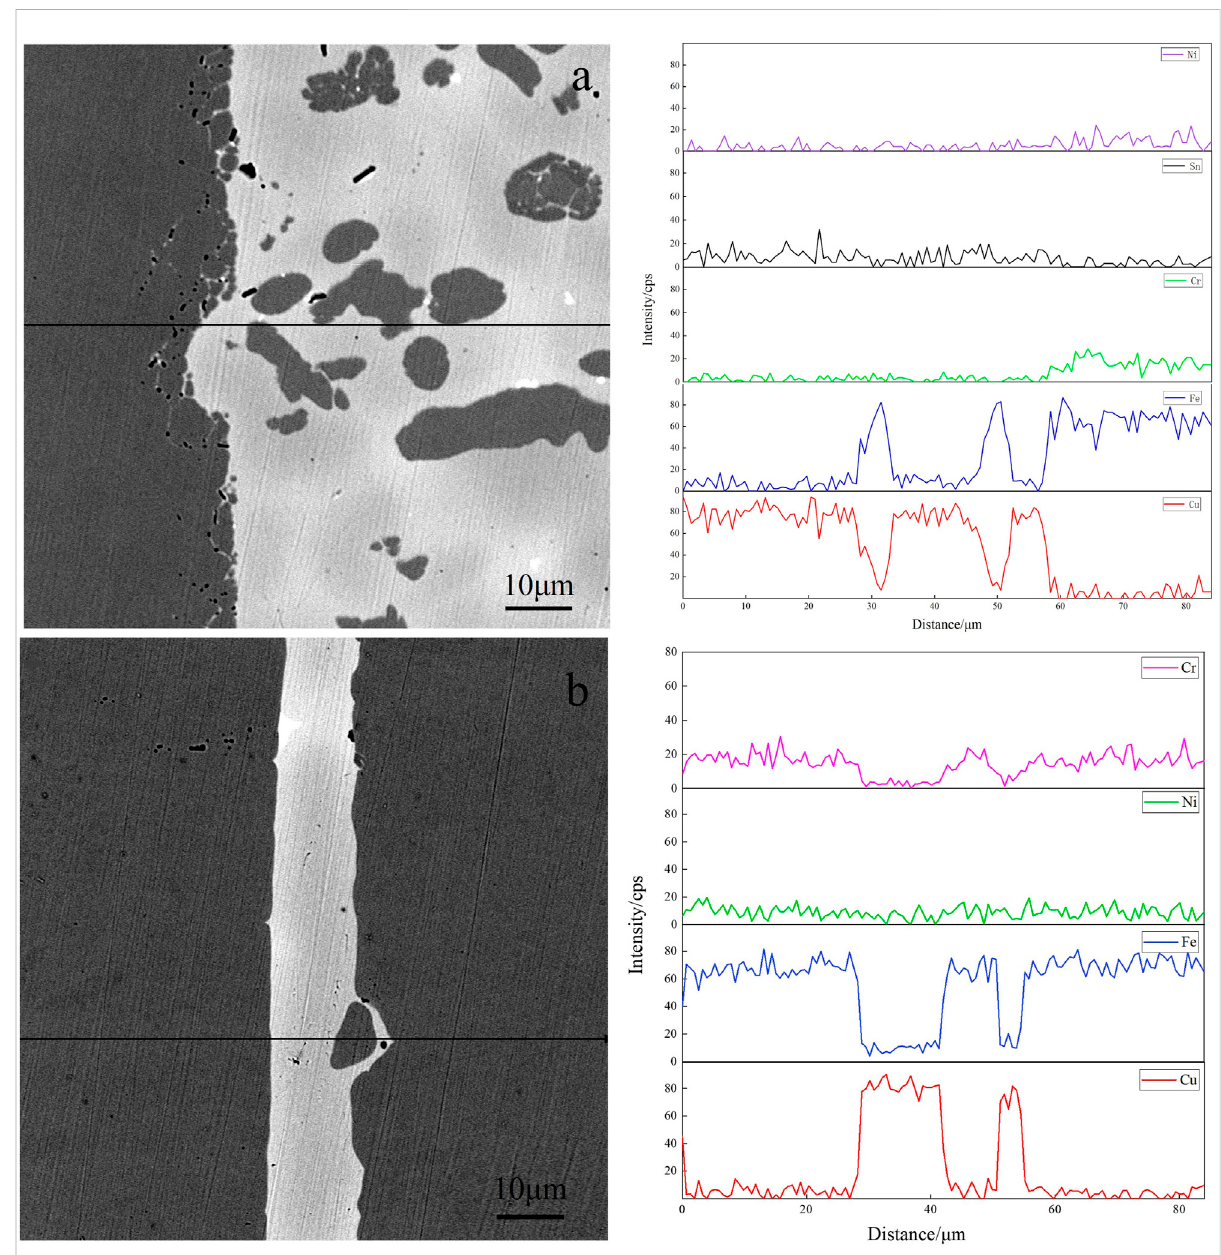
FIGURE 9 SEM image and EDS line scanning of elements with two brazed joints (A) alloy obtained by melting the circuit board and (B) alloy obtained by pure